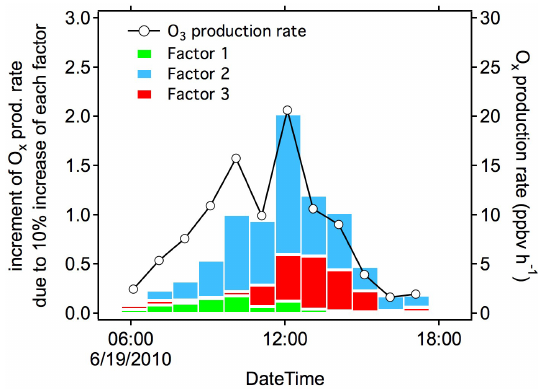
Figure 8. Diurnal variation in the sensitivity of each source to in situ O x photochemical production and P(O x ) on 19 June